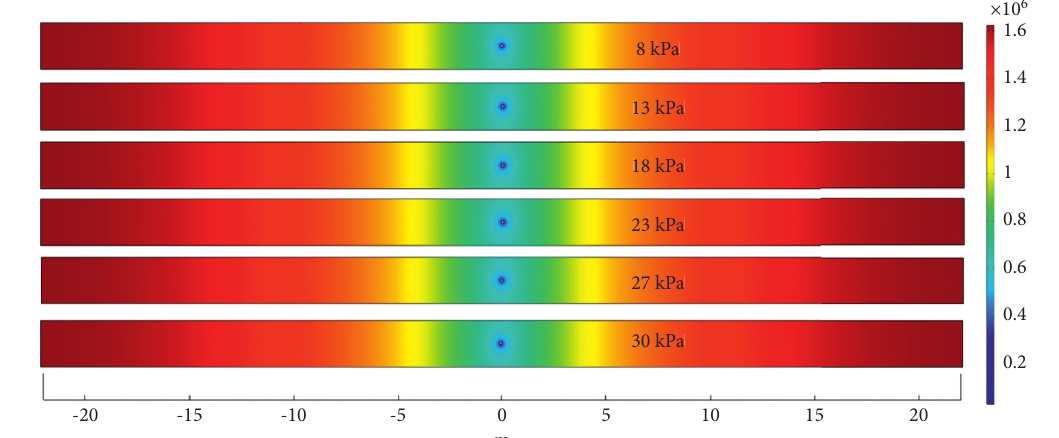
Figure 1: Geometric model.